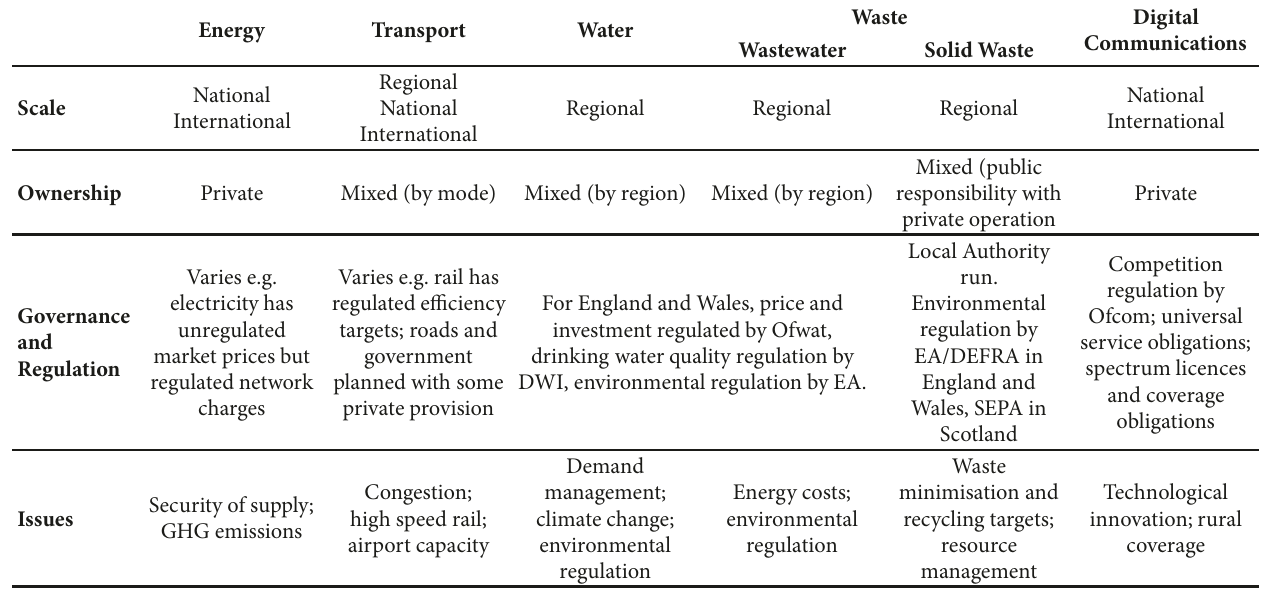
Table 1: Characteristics of the UK National Infrastructure System (adapted from Hall et al. [15]).